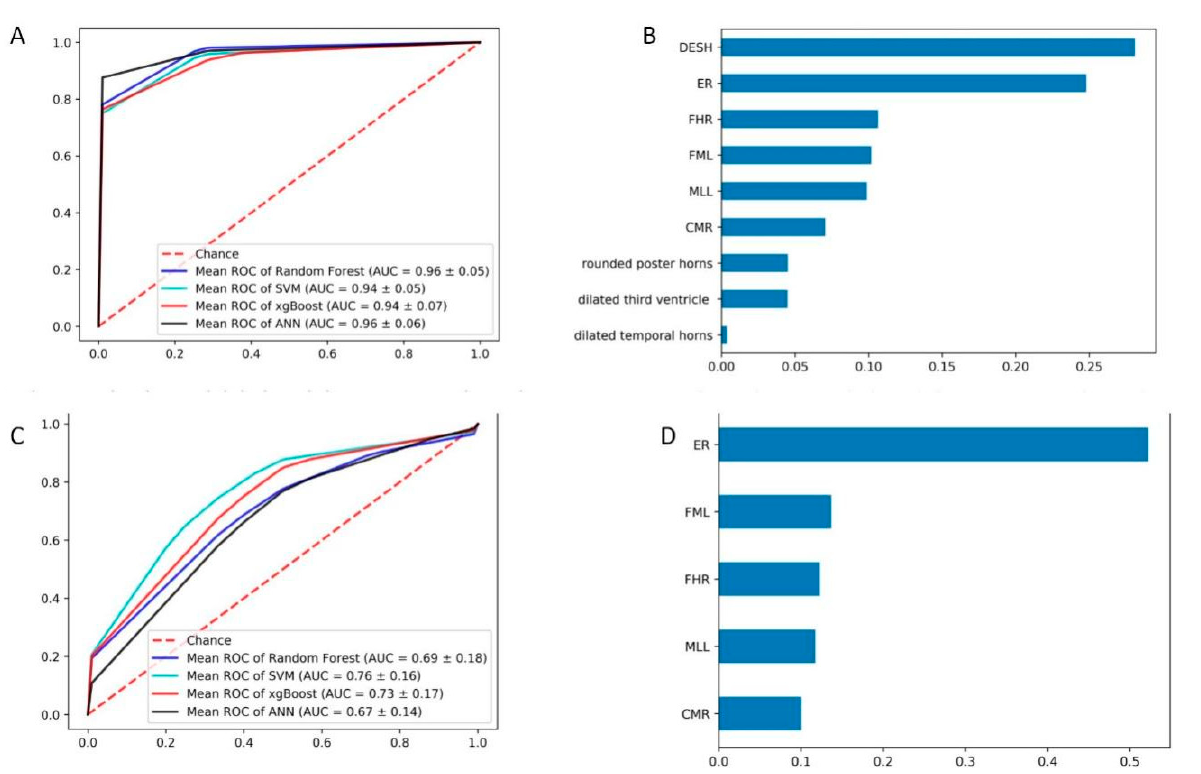
Figure 3. The comparison of hydrocephalus group and symptomatic group in terms of ROC and weight. ( A ) ROC curves of the four derived models with radiological features; RF, random forest, XG, XGBoost; ANN, artificial neural network; SVM, support vector machine for the patients with hydrocephalus and normal control; ( B ) The weight of all features; ( C ) ROC curves of the four derived models with morphometric parameters; ( D ) The weight of all features morphometric param ‐ eters.